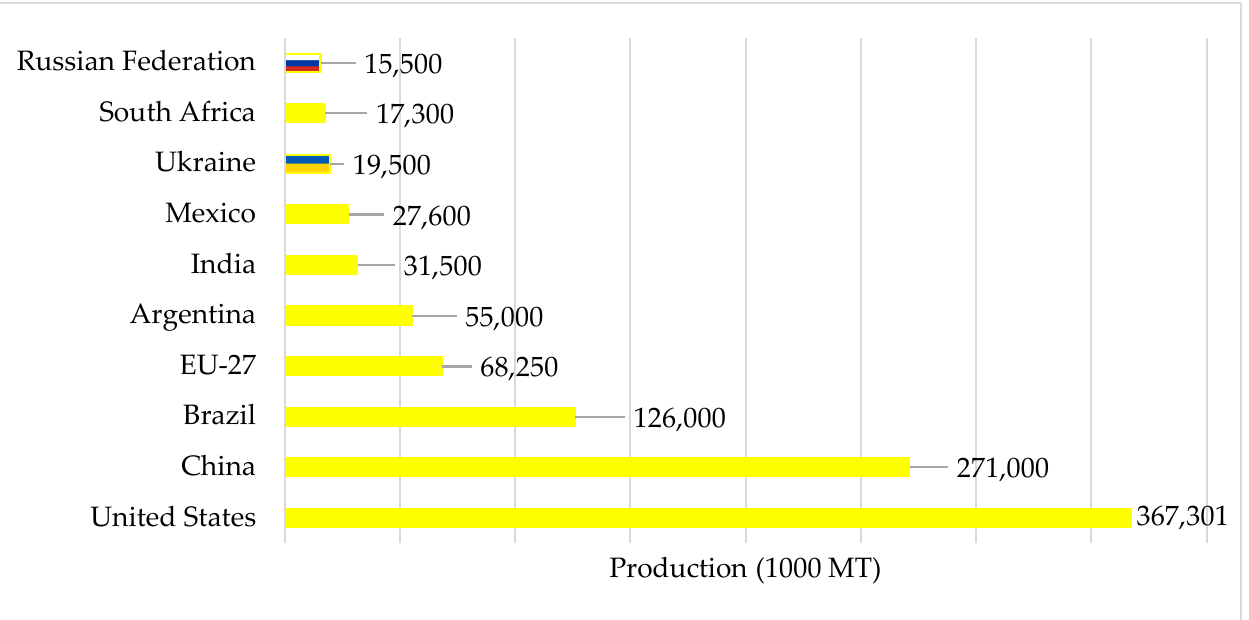
Figure 3. Estimated maize production in 2022. Source: [25]. Table 1 presents that during the conflict period, Russia’s average wheat and soybean production increased (2022–2023). The reverse situation occurred in Ukraine, where the production of wheat, soybeans, and maize fell drastically. Table 1. Average production of wheat, soybeans, and maize in Russia and Ukraine in 2017–2023 . Country